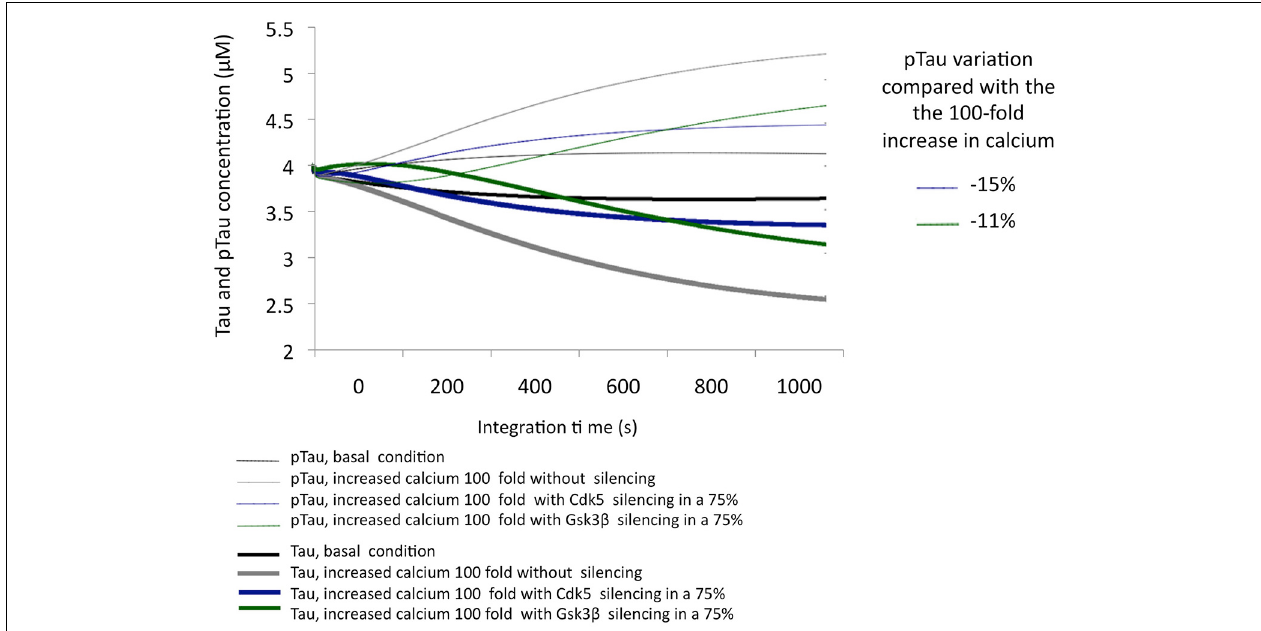
FIGURE 5 | Variation in the levels of Tau and pTau in response to the SIS of CDK5 and GSK3 β in conditions simulating excitotoxicity with a 100-fold increase in calcium. CDK5 and GSK3 β were silenced by 75%. The inset in the graph indicates the decrease in pTau in response to increased calcium.